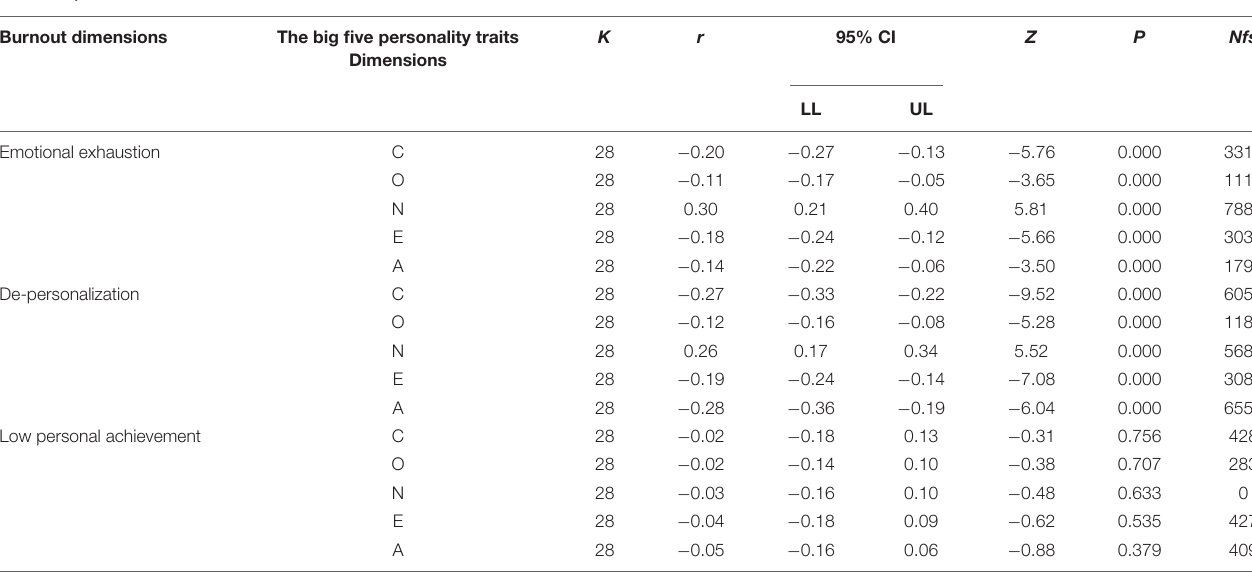
TABLE 3 | Main effect test